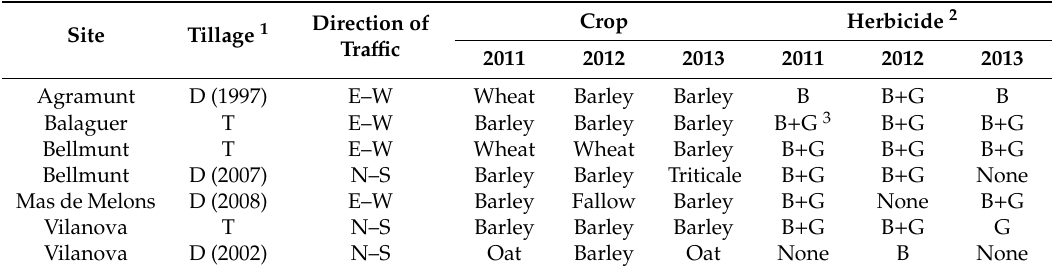
Table 1. Location of the fields, soil management, crops, and herbicide application carried out in each field and